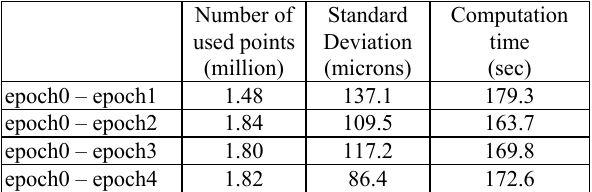
Table 3. Numerical results of the cross-epoch co-registration computations.